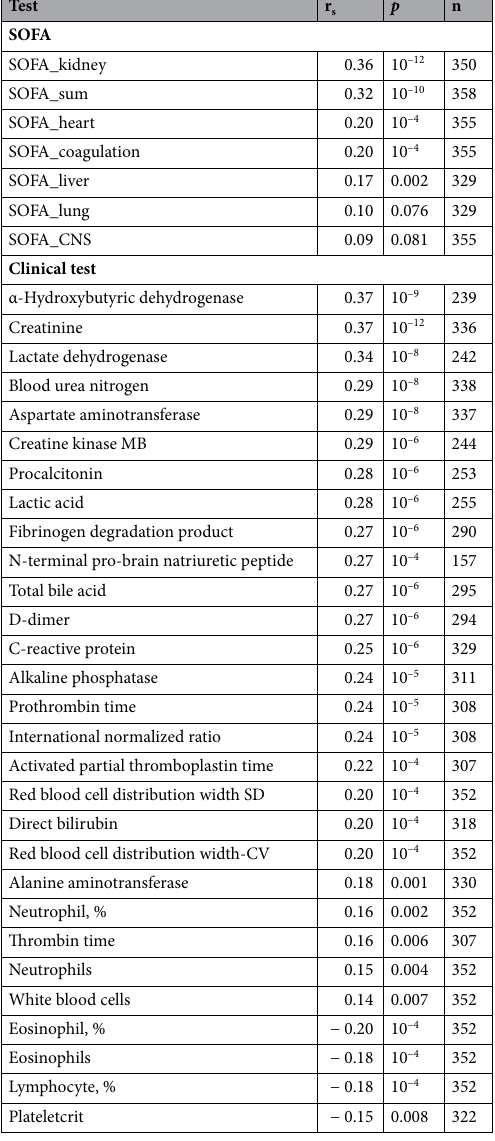
Table 3. Association of plasma NPC2 with SOFA scores and values of clinical tests of sepsis patients. Only tests with p < 0.01 are listed. Correlation coefficients (r s ) were obtained by using the Spearman’s rank-order